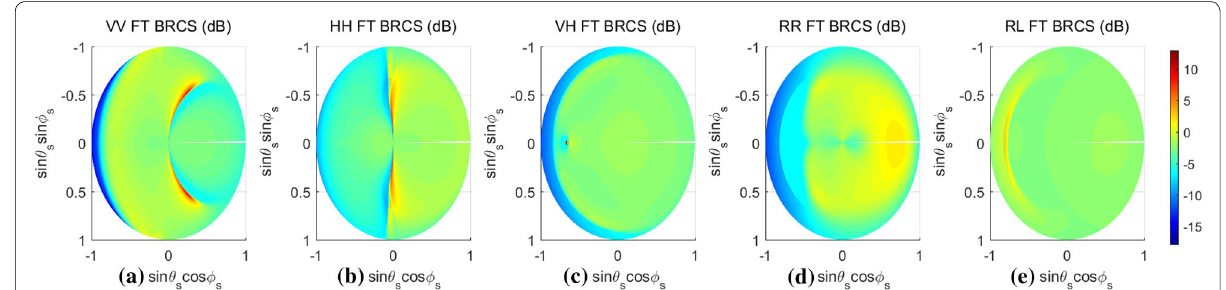
Fig. 3 BRCS differences as the soil temperature changes from frozen state ( circular polarization (RR and RL)